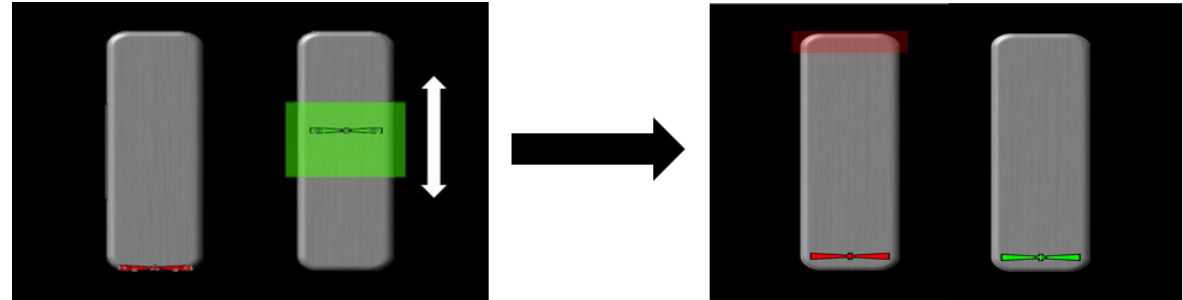
Figure 3. Pedals Emergency Stop© moving gas target ( left ) and brake target ( right